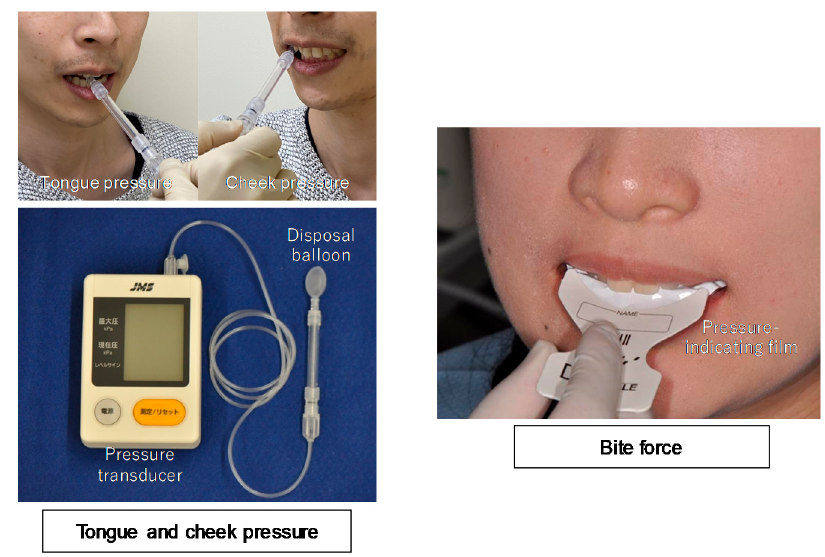
Figure 2. Description of tongue pressure, cheek pressure, and bite force measurements.